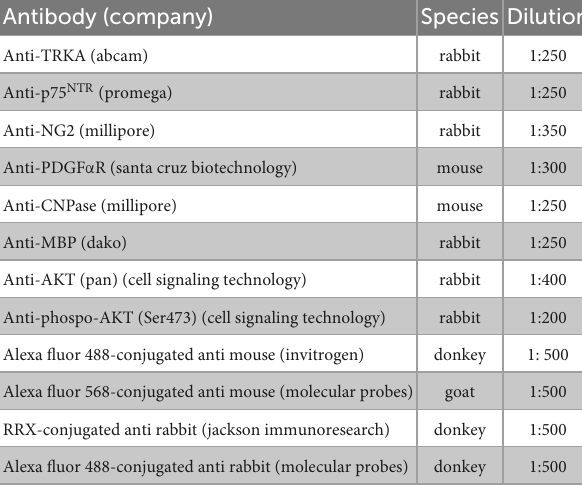
TABLE 1 List of primary and secondary antibodies used in the immunocytochemistry reactions. Antibody